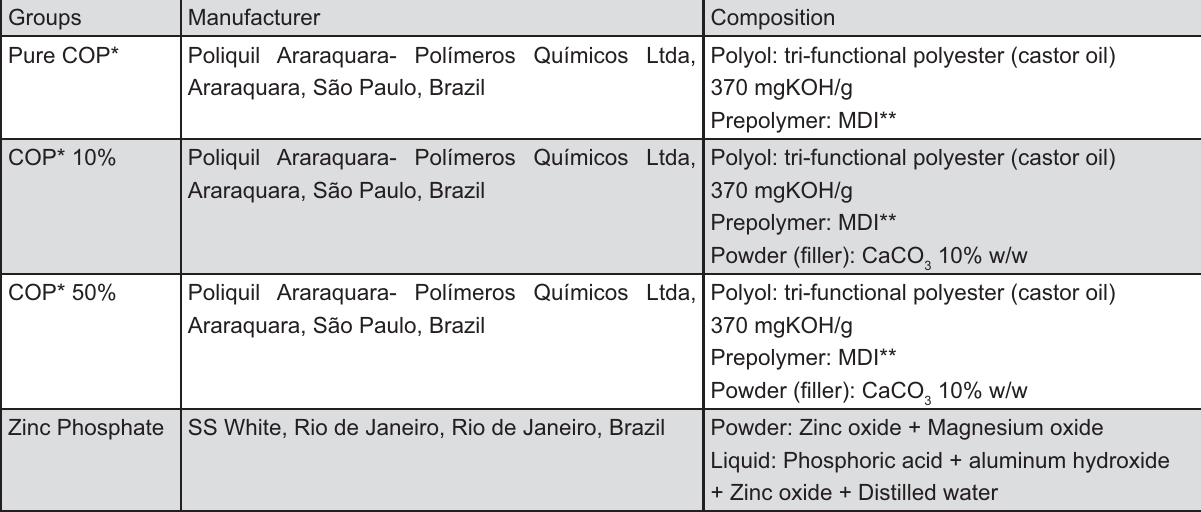
Figure 1- Experimental groups, manufacturers and compositions of materials used in this